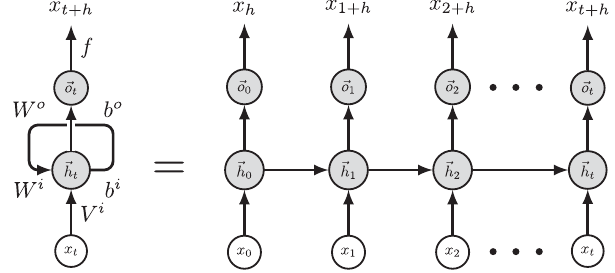
FIG. 2. Illustration of an RNN cell in folded and unfolded